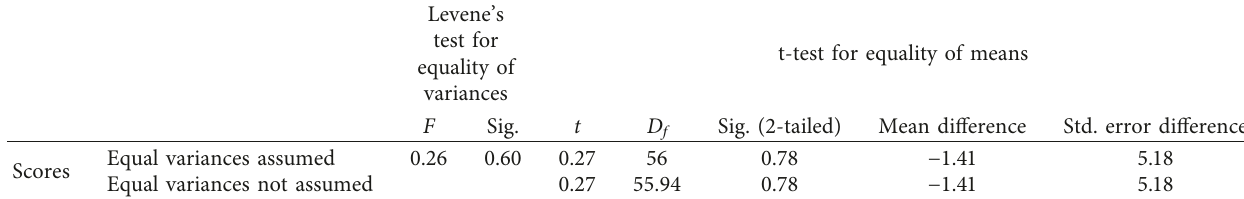
Table 2: Inferential statistics (anxiety pretest of both groups).